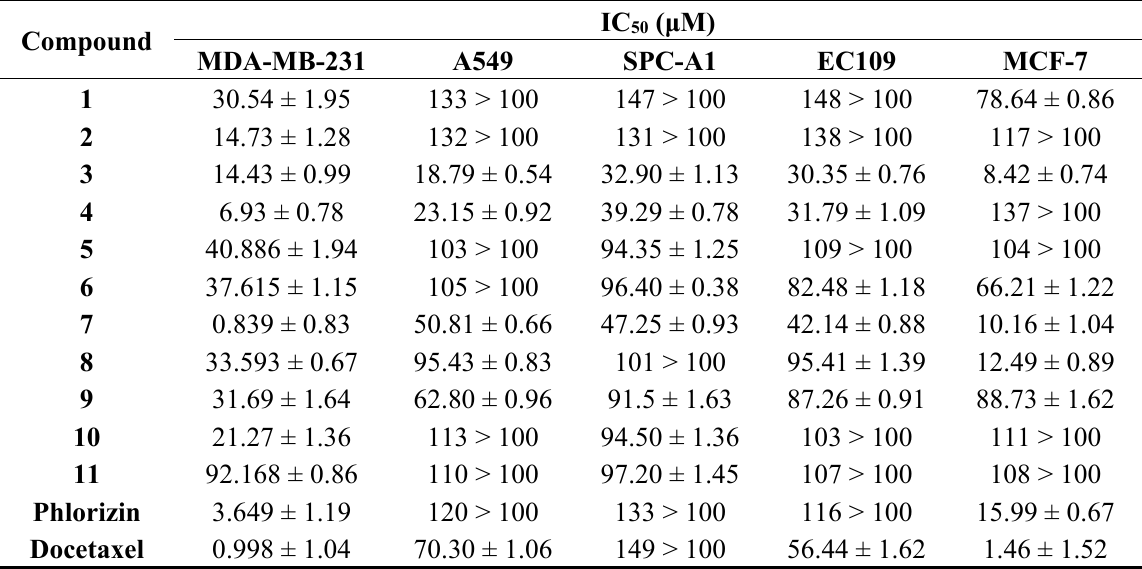
Table 1. In vitro anti-proliferative activity of 1 – 11 against human cancer cell